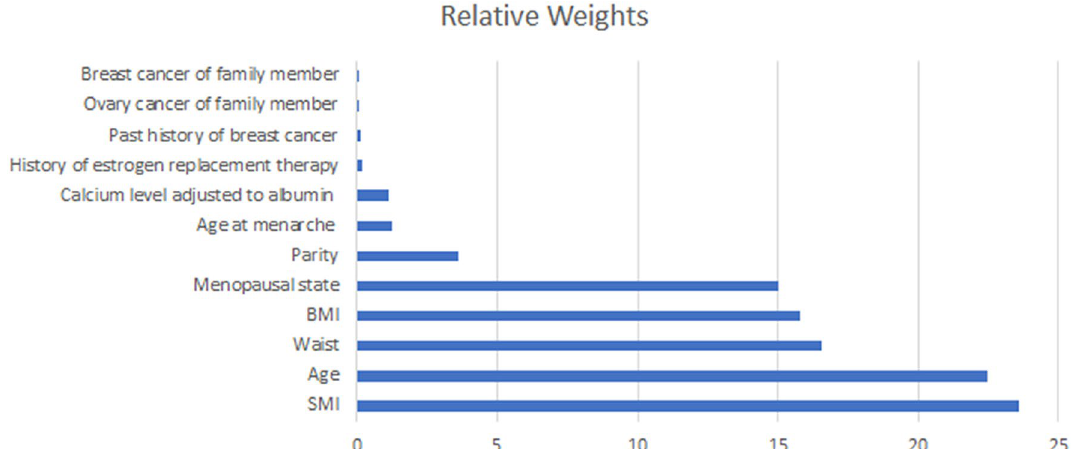
Figure 2. Relative weights for the association of mammographic density with predicting factors. BMI: body mass index; SMI: skeletal muscle mass index; Waist: Waist circumference.